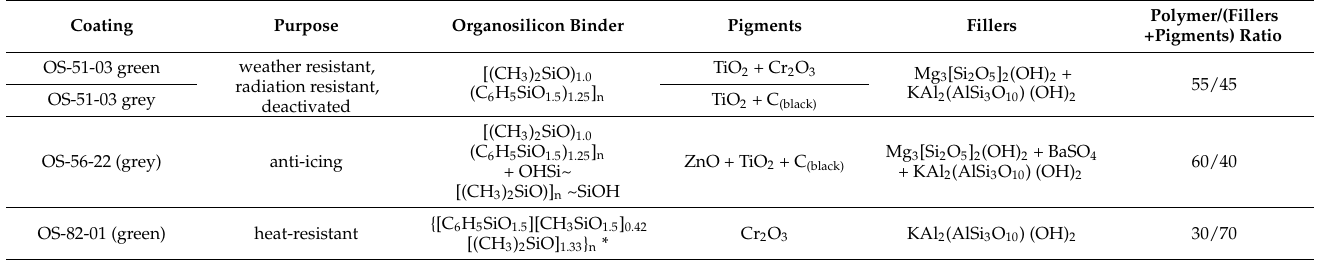
Table 1. Organosilicate coatings compositions and thicknesses.